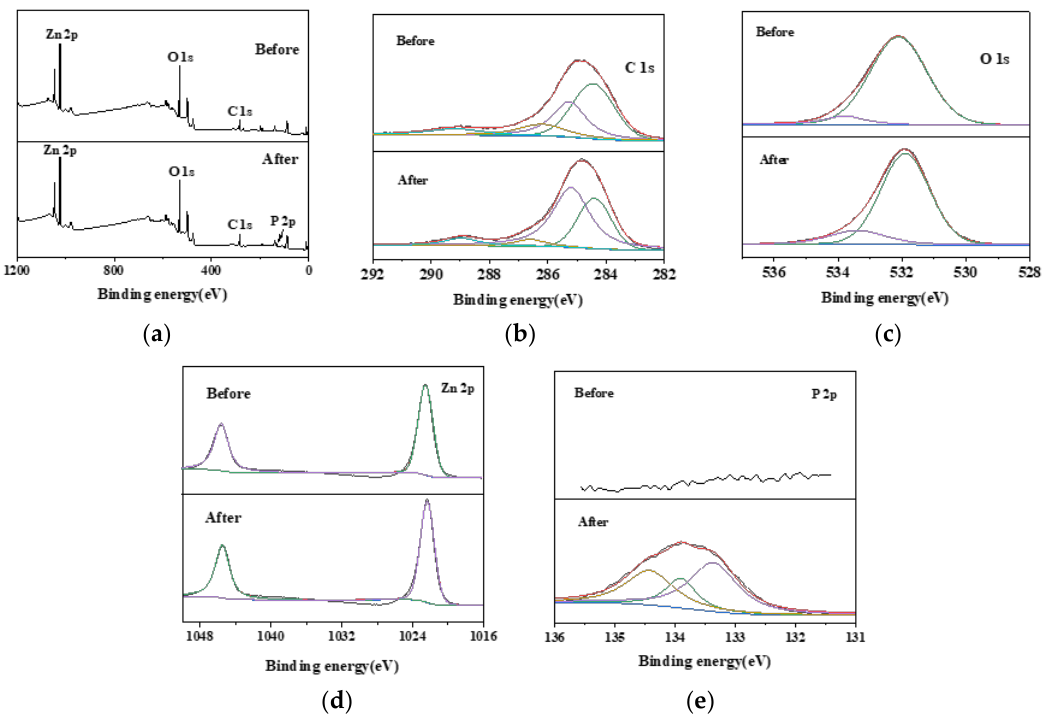
Figure 2 . XPS results before and after adsorption of nZVZ–MSBC. ( a ) Total sample spectrum, ( b ) C 1s spectrum, ( c ) O 1s spectrum, ( d ) Zn 2p spectrum, and ( e ) P 2p spectrum. Compared with the results before adsorption, the decrease in C–H content and in- crease in C–C content indicated that chemical reactions were involved in the adsorption process, resulting in a change in chemical bond components. The decrease in the peak area of the O element showed that nano-zero-valent zinc was oxidized in the adsorption pro- cess and participated in the reaction. The composition of the Zn element did not change significantly, but the peak area decreased; this may have been related to Zn participating in the reaction and forming a chemical precipitate. The crystal morphology of the composite was analyzed by X-ray diffraction (XRD), and the data were analyzed using the Jade6.0 software. Figure 3 shows that the diffraction peak of C in the composite was entirely consistent with (PDF # 46-0943), but the diffraction peak of Zn was not detected. This might have been due to the excellent dispersion of nano- zero-valent zinc in the material, which did not form crystals. Figure 3. XRD results of MSBC and nZVZ–MSBC. According to the results of the BET test, the specific surface area of the nZVZ–MSBC composite reached 162.7 m 2 /g, the total adsorption pore volume was 0.61 cm 3 /g, and the average pore width was 15.1 nm (Table 1). Compared with those of the municipal sludge biochar raw materials, the specific surface area and pore volume more than doubled, and the average pore width slightly increased. This also showed that the nano-zero-valent zinc was uniformly dispersed on the surface of the MSBC and that there was no agglomeration to block the holes [25]. The nitrogen adsorption–desorption curve and pore size distribu- tion curve of the sample are shown in Figure 4, indicating protrusion in the direction of the Y axis in the low-pressure zone and capillary condensation in the high-pressure zone. According to the IUPAC classification, the sample was a type IV isotherm with a typical H3 hysteresis loop. Its adsorption and desorption curves were typical for mesoporous 20